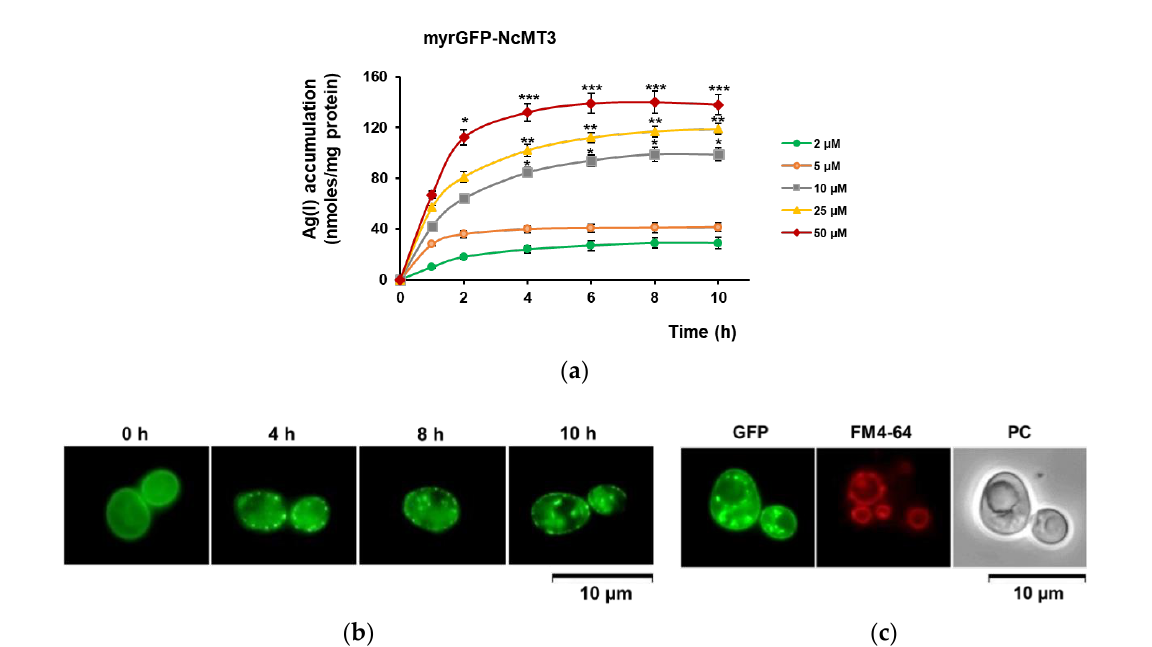
Figure 5. Ag(I) accumulation by the Ag(I)-tolerant strain myrGFP-NcMT3. The cup2 ∆ cells transformed with URA3 -based plasmid harboring myrGFP-NcMT3 under the control of GAL1 promoter were pregrown in MM/Raf-Ura, then shifted to galactose medium for transgene induction. ( a ) Effect of Ag(I) concentration on Ag(I) accumulation. Transformed cells pregrown in MM/Raf-Ura were shifted to MMLC/Gal-Ura and incubated 6 h for transgene induction (30 ◦ C, 200 rpm) before Ag(I) was added to the specified concentrations. Cells were incubated with Ag(I) for various times and harvested for metal assay. Two-way ANOVA followed by Bonferroni’s test compared to the data obtained for 1 µ M Ag(I) (shown in Figure 3b). * p < 0.05; ** p < 0.01; *** p < 0.001. ( b ) Effect of high Ag(I) on myrGFP-NcMT localization. Cells incubated with 25 µ M Ag(I) were harvested at various times for myrGFP-NcMT3 visualization by fluorescence microscopy. ( c ) Localization of myrGFP-NcMT3 at the vacuolar membrane. Cells expressing myrGFP-NcMT3 exposed for 10 h to 25 µ M Ag(I) were incubated with FM4-64 for vacuole membrane straining. Cells were visualized by fluorescence microscopy ( λ excit 460–480 nm, λ emiss 495–540 nm for GFP; λ excit 540–550 nm, λ emiss 575–625 nm for FM4-64). PC = Phase